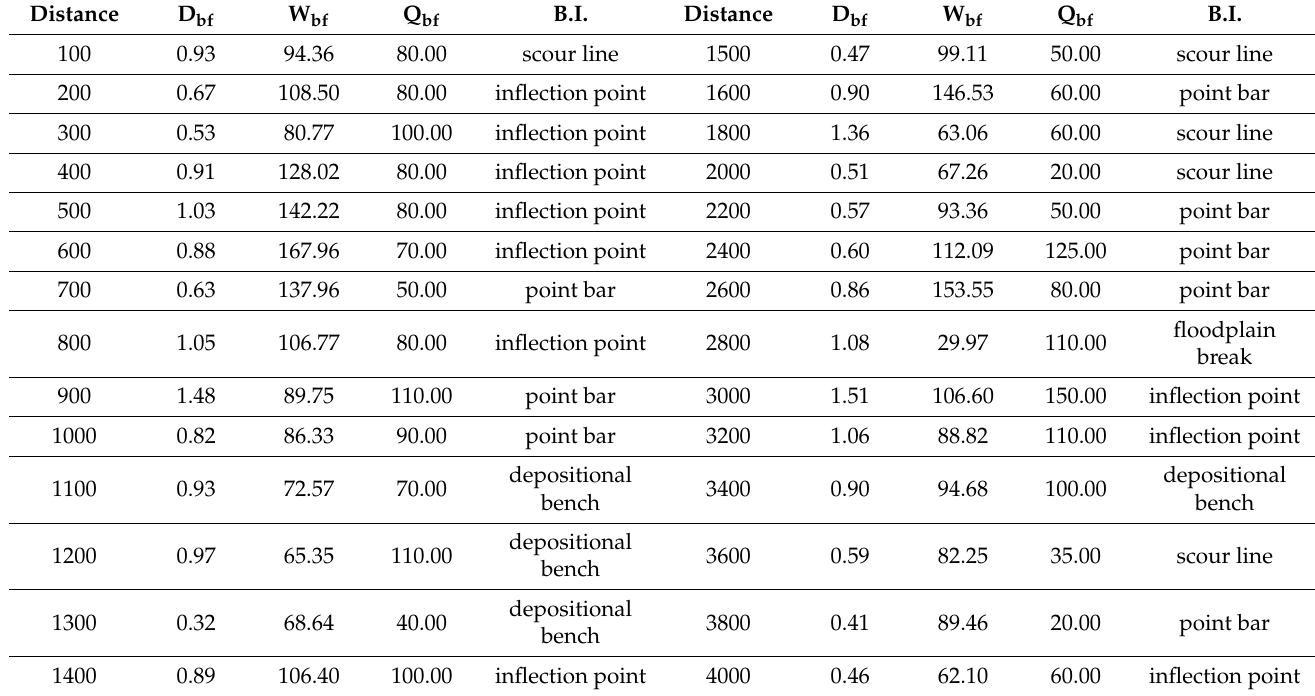
Table 1. Estimated bankfull discharge at the Byeongseong river (bankfull mean depth (D bf ; m); bankfull width (W bf ; m); bankfull discharge (Q bf ; m 3 /s); bankfull indicator